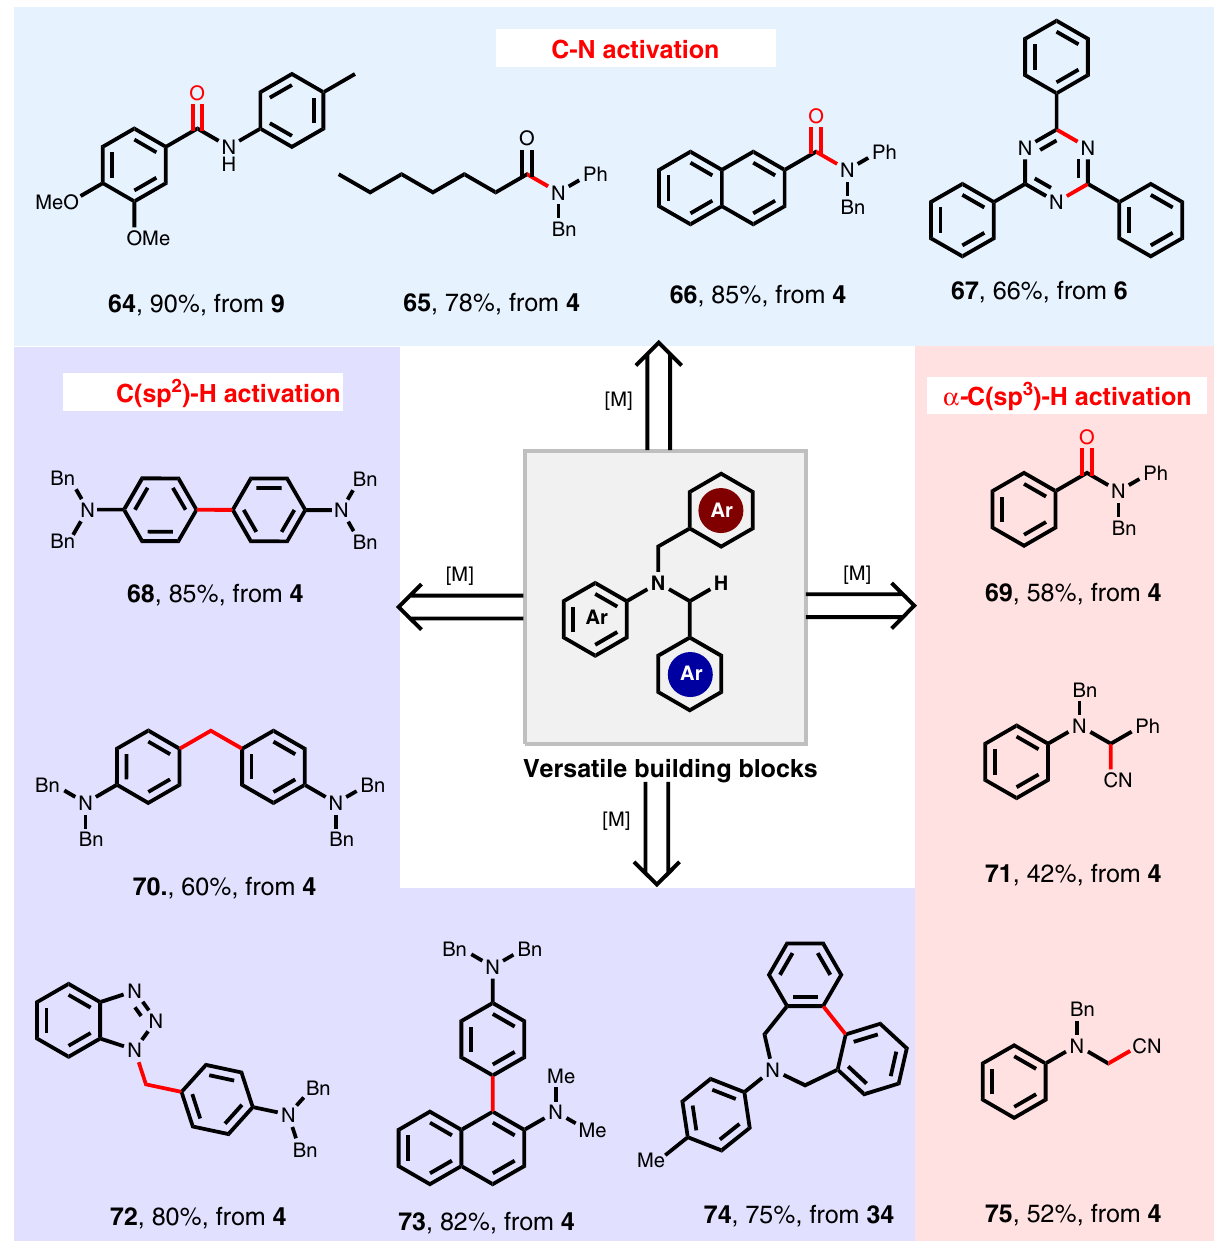
Fig. 4 Synthetic application of derivatization of aromatic tertiary amines. [M] = Metal reagent. See Supplementary Information for detailed experimental